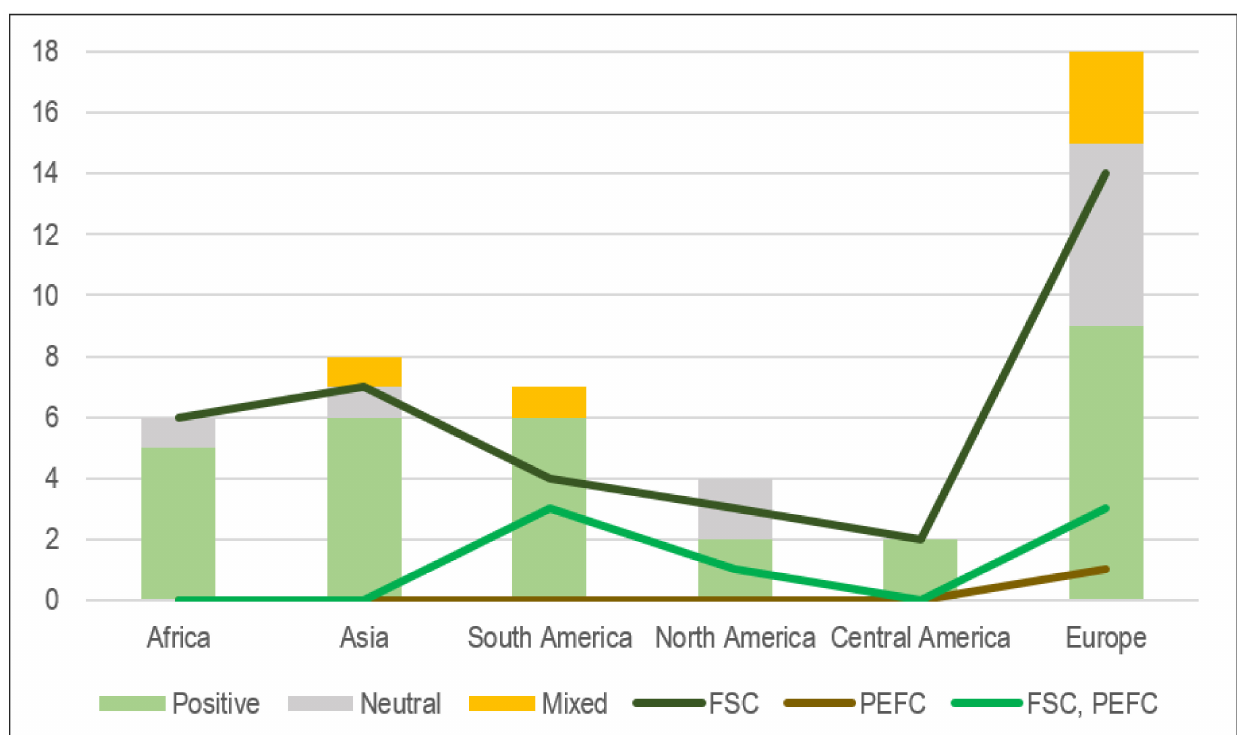
Figure A2. Distribution of empirical studies on deforestation, illustrated by impact and certifica- tion scheme.